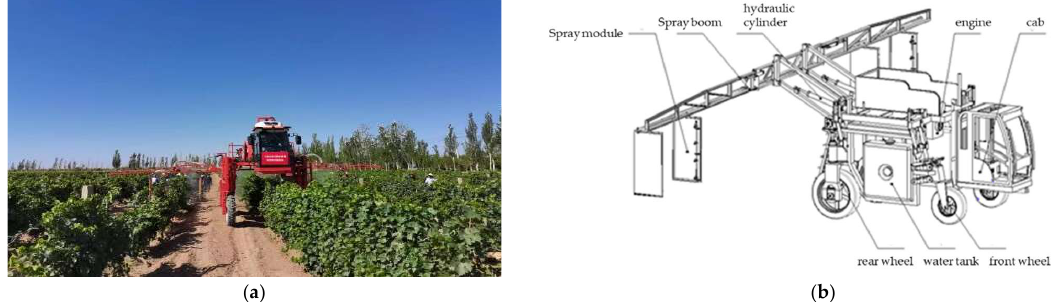
Figure 1. High Clearance Sprayer solid diagram and mapped 3D diagram. ( a ) is the high clearance spray machine prototype; ( b ) is the high clearance spray machine model.